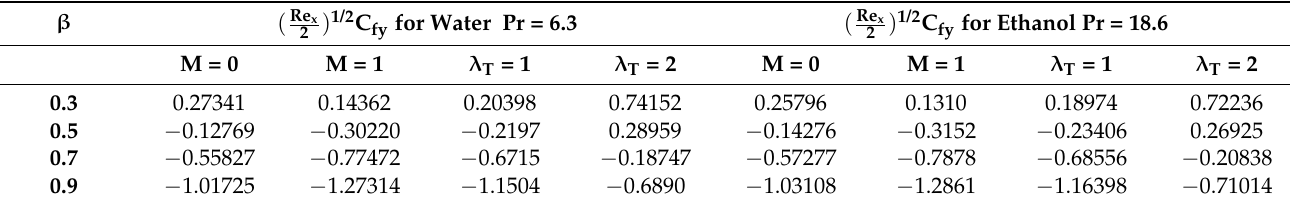
Table 2. Skin friction C fy for different values when λ M = A = 0.5, B = 0.8.